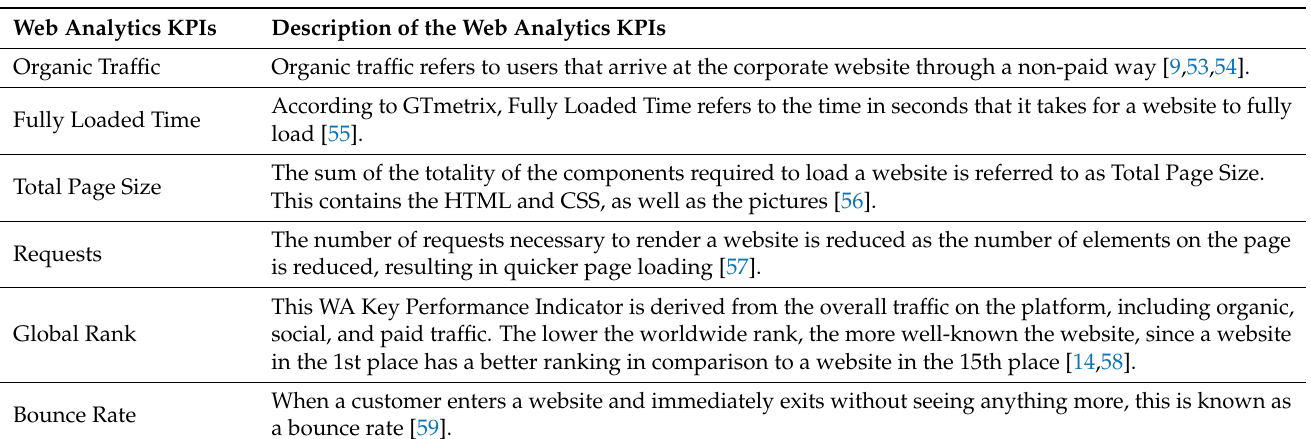
Table 1. Presentation of the extracted Web analytics